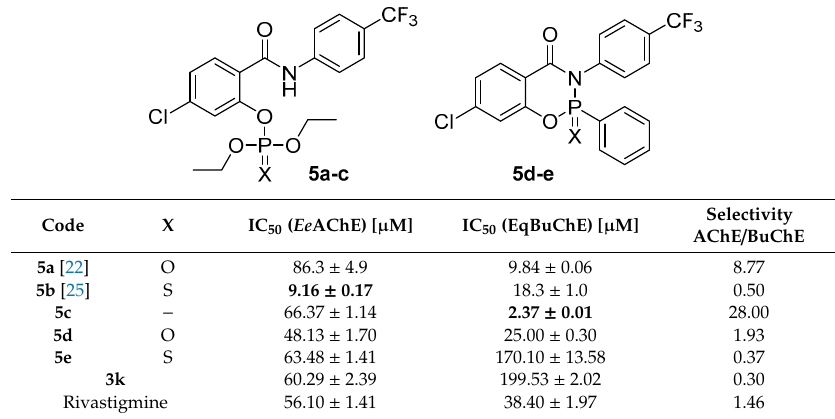
Table 2. Phosphorus-bases inhibitors of AChE and BuChE.